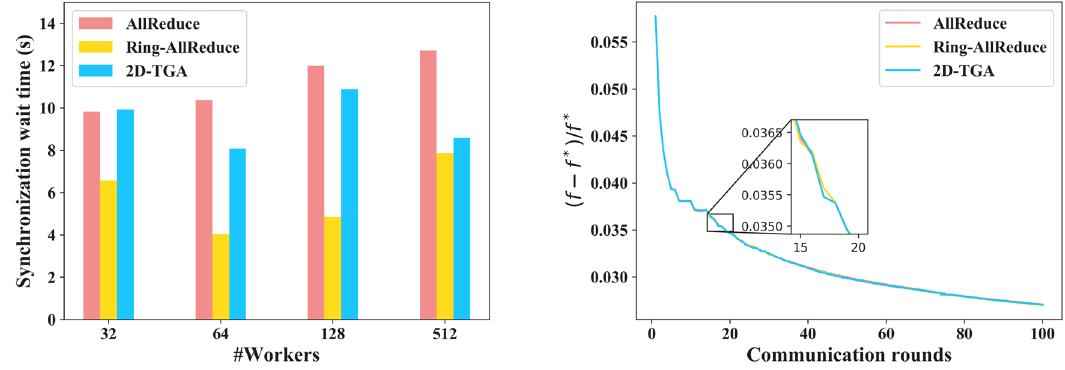
Fig. 5 Experimental results of url